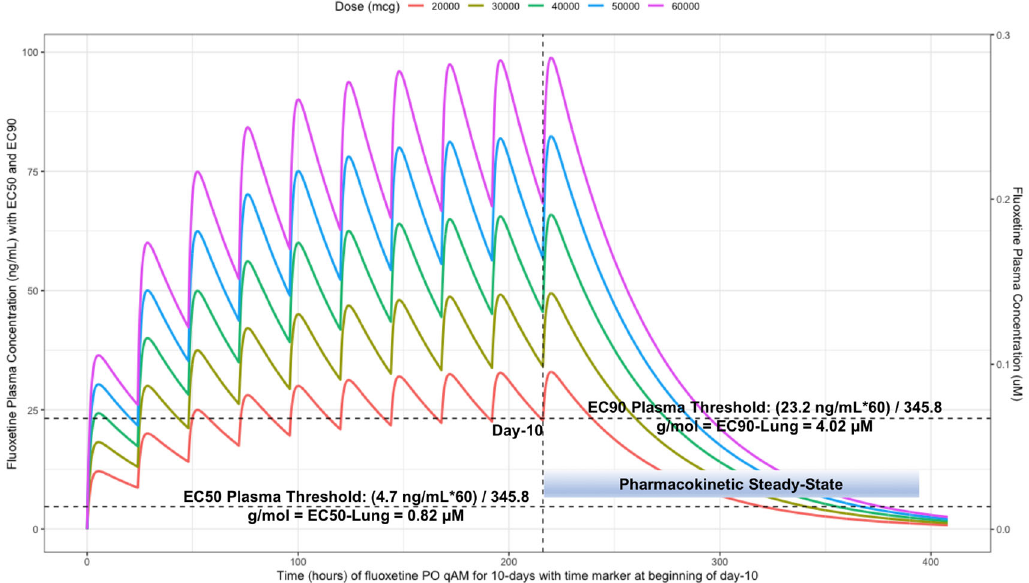
Figure 6. Fluoxetine concentration-time profile in human plasma at standard daily antidepressant doses (20 mg/day, 30 mg/day, 40mg/day, 50 mg/day, 60 mg/day) throughout 10 days. The vertical line illustrates the morningdoseonday-10,thehighest(EC90)andlowest(EC50)horizontallinesillustratesthethresholdfortheplasma effective concentrations inhibiting 50% and 90% of SARS-CoV-2 titers that distributes to 60-times higher concentra- tions within the lungs, respectively.